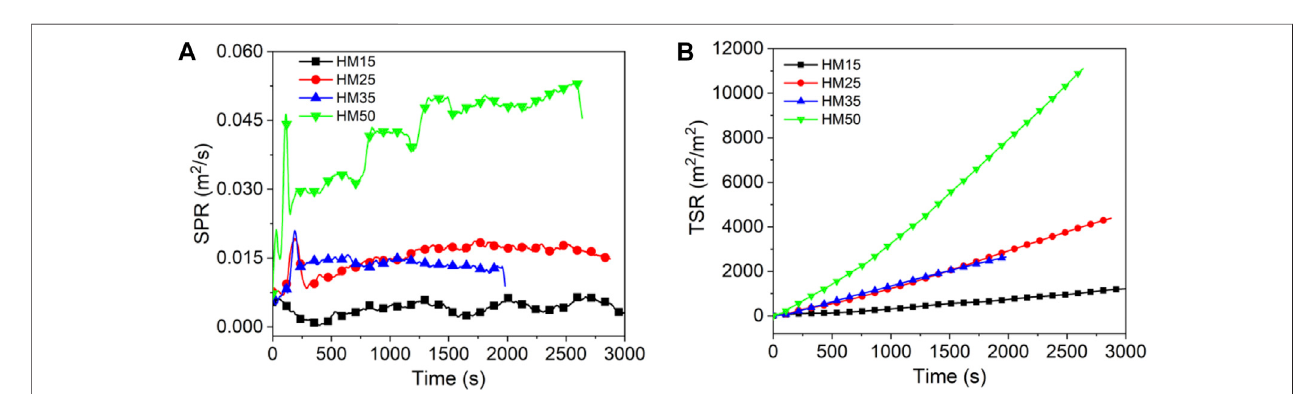
FIGURE 4 | Lignite curves: (A) SPR, and (B)